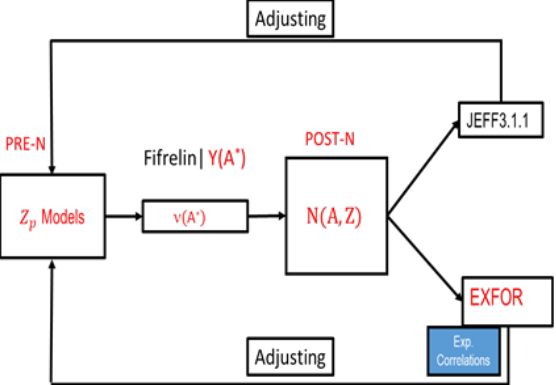
Fig. 2. The scheme for calculating and adjusting the Zp model